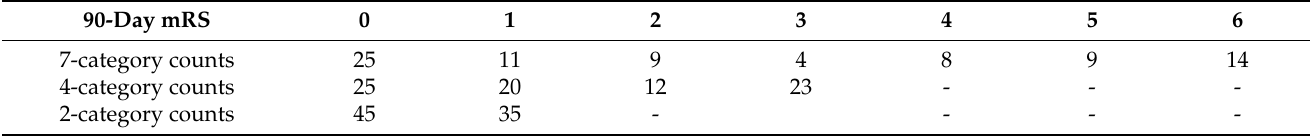
Table 4. Distributions of 90-day mRS in the three situations.